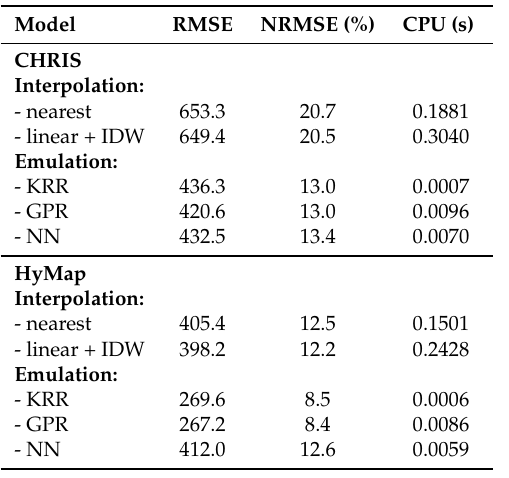
Table 1. Interpolation vs. emulation validation results and CPU time for CHRIS ( top ) and HyMap ( bottom ) SPARC